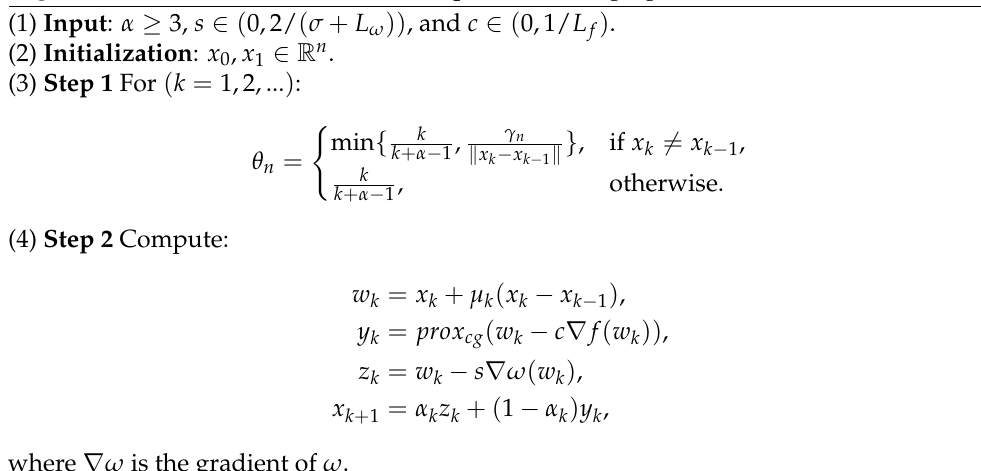
Algorithm 2 Inertial Bilevel Gradient sequential Averaging Method (iBiG-SAM)